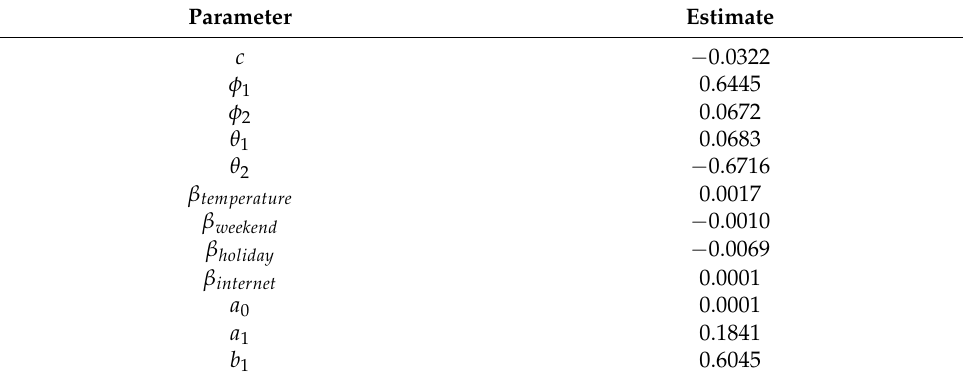
Table 4. Parameter estimations of the ARIMA ( 2,0,2 )( 0,1,0 ) perature, weekend, holiday, and Internet traffic variables.